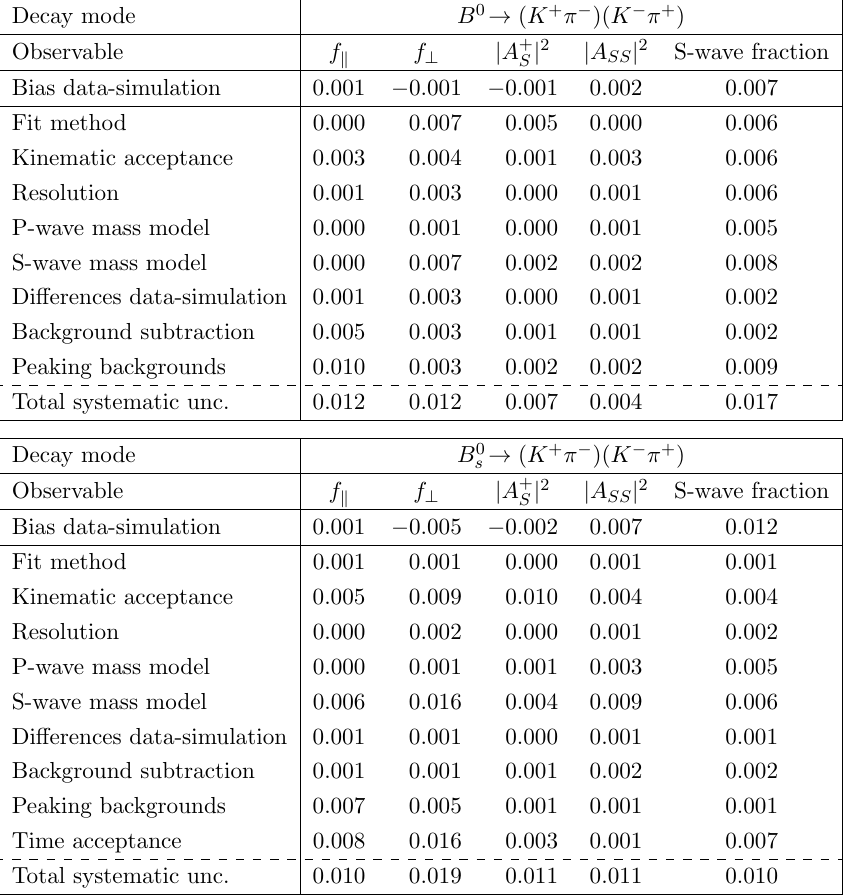
Table 7 . Systematic uncertainties for the derived observables of the amplitude-analysis (cid:12)t of the B 0 ( K + (cid:25) (cid:0) )( K (cid:0) (cid:25) + ) decay. The bias related to di(cid:11)erences between data and simulation is ( s ) ! included in the results shown in table